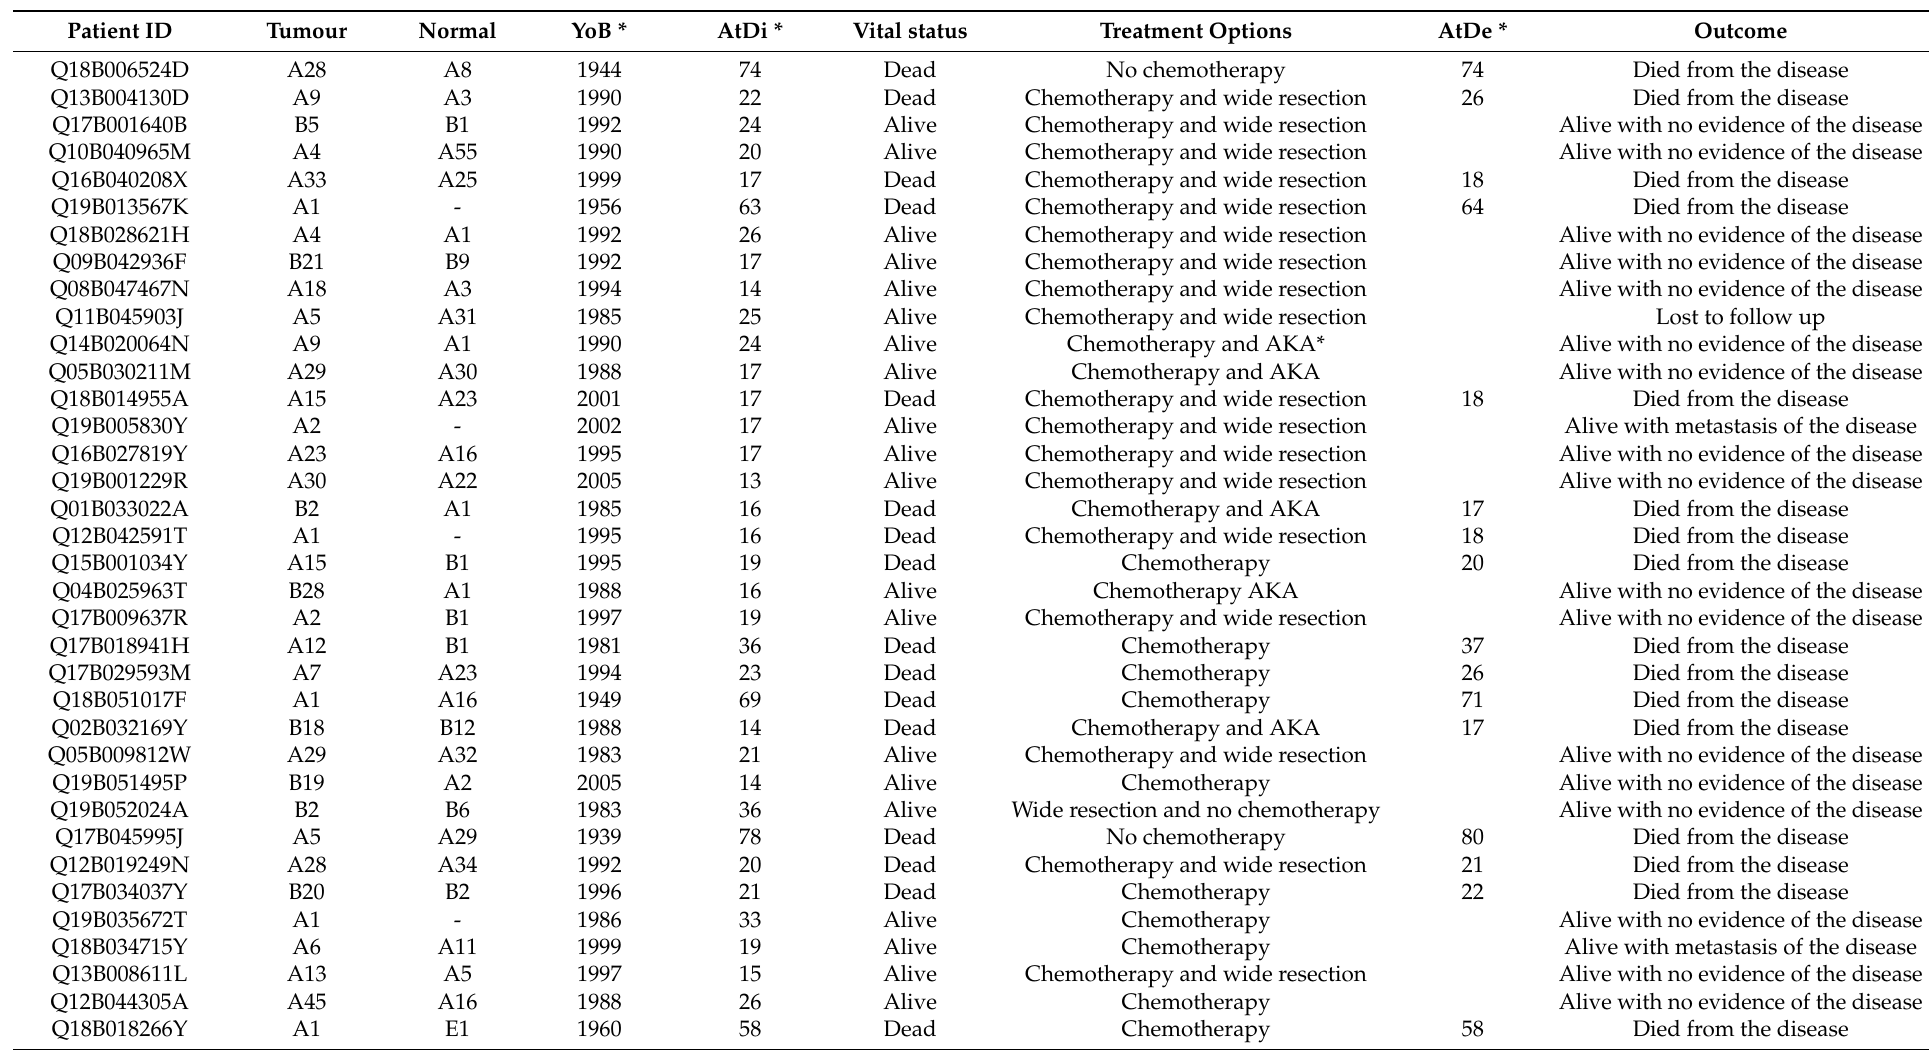
Table 1. Characteristics of osteosarcoma patients in the present